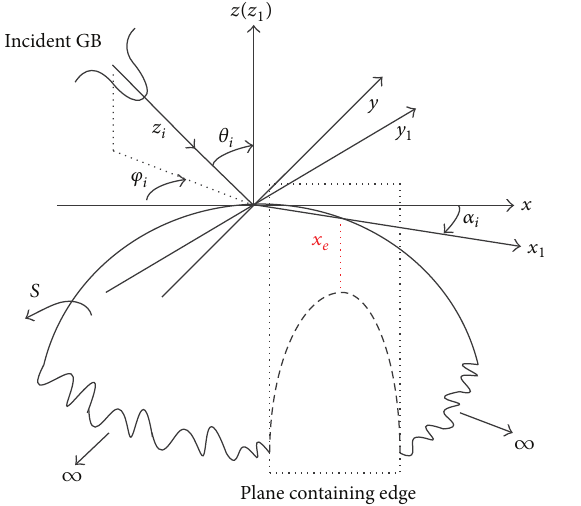
Figure 2: 3D GB diffraction from a semi-infinite surface containing aplaneedge. ̂𝑥̂𝑦̂𝑧 istheprincipalcoordinateattheintersectionpoint and the edge lies at ̂𝑥 = 𝑥 𝑒 plane.